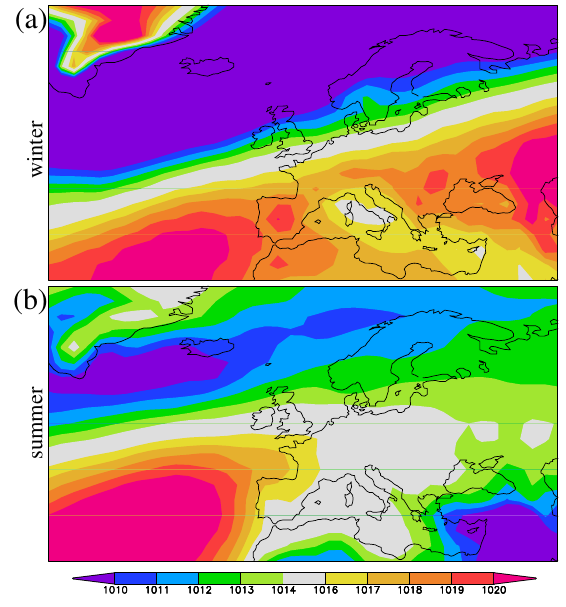
Fig. 5. Climatology of mean sea-level pressure anomalies [hPa] in winter (a) October–March, and summer (b) April–September.